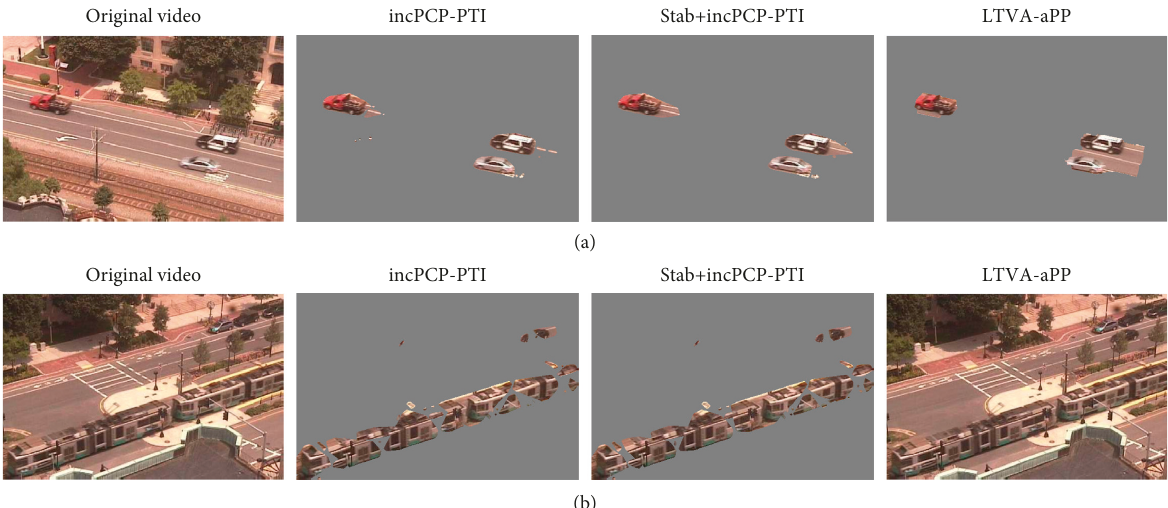
Figure 9: Frames 1330 (a) and 1870 (b) of the video and the segmented sparse components for the IP video obtained with incPCP-PTI, stab+incPCP-PTI, and LTVA-aPP. It is observed that LTVA is unable to separate the moving objects in frame 1870. This figure is a modified version of Figure 7 in [28].